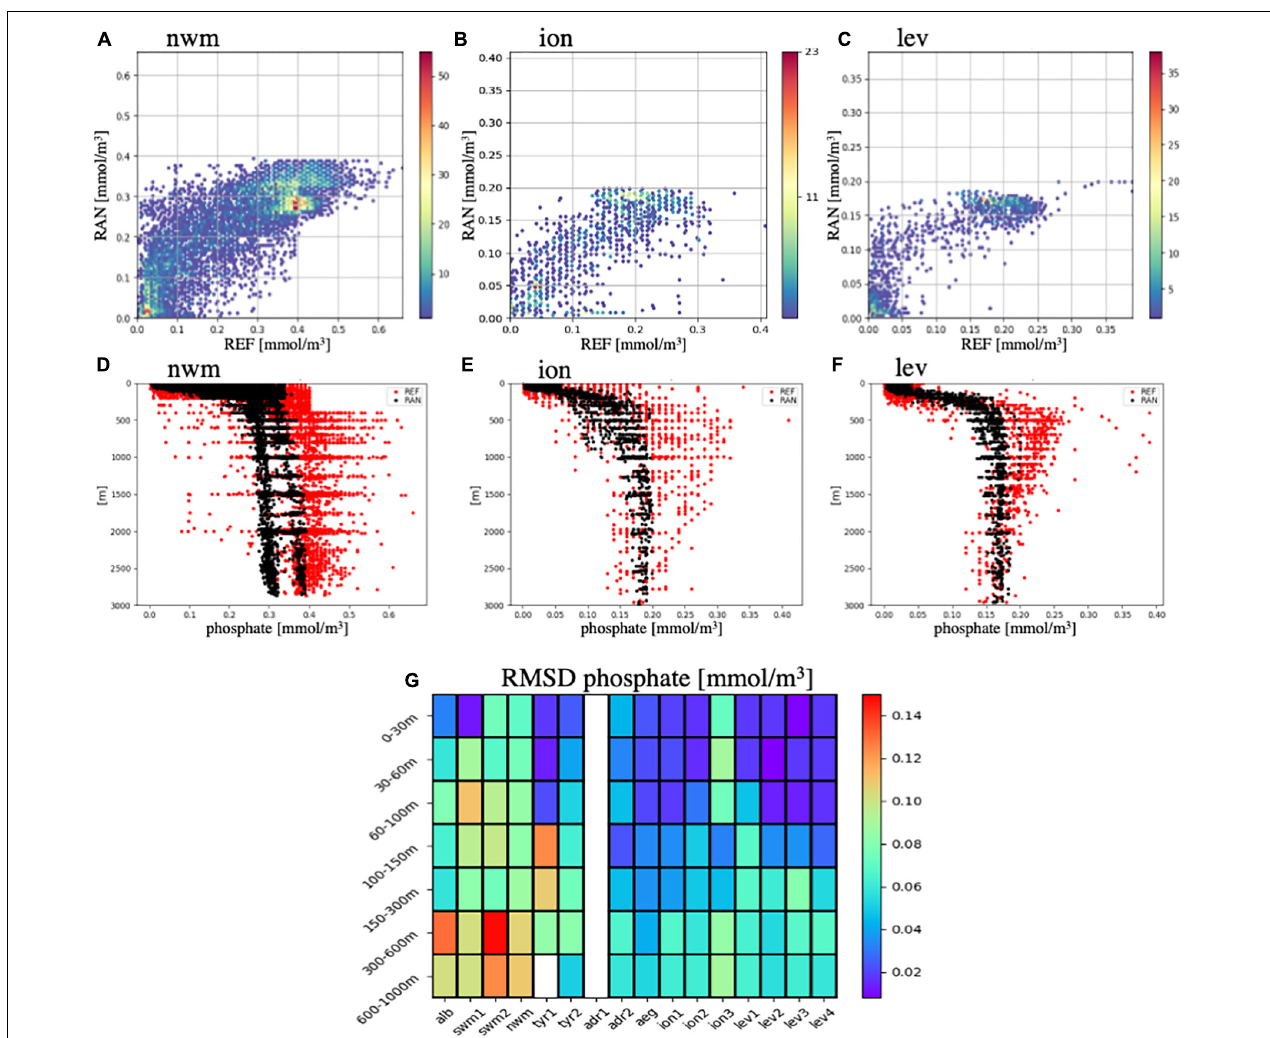
FIGURE 5 | Level 2 validation for phosphate based on the match-ups between model results and reference EMODnet_int dataset for three sub-basins (nwm, ion and lev) in the open sea. (A–C) Density plots of model (RAN) and EMODnet_int (REF) match-ups; (D–F) vertical profiles for reanalysis (RAN, black) and reference dataset (REF, red); n. of match ups are 10,774 (nwm), 1,410 (ion) and 1623 (lev); (G) RMSD (mmol/m 3 ) computed for selected vertical layers and for each sub-basin (white boxes correspond to data